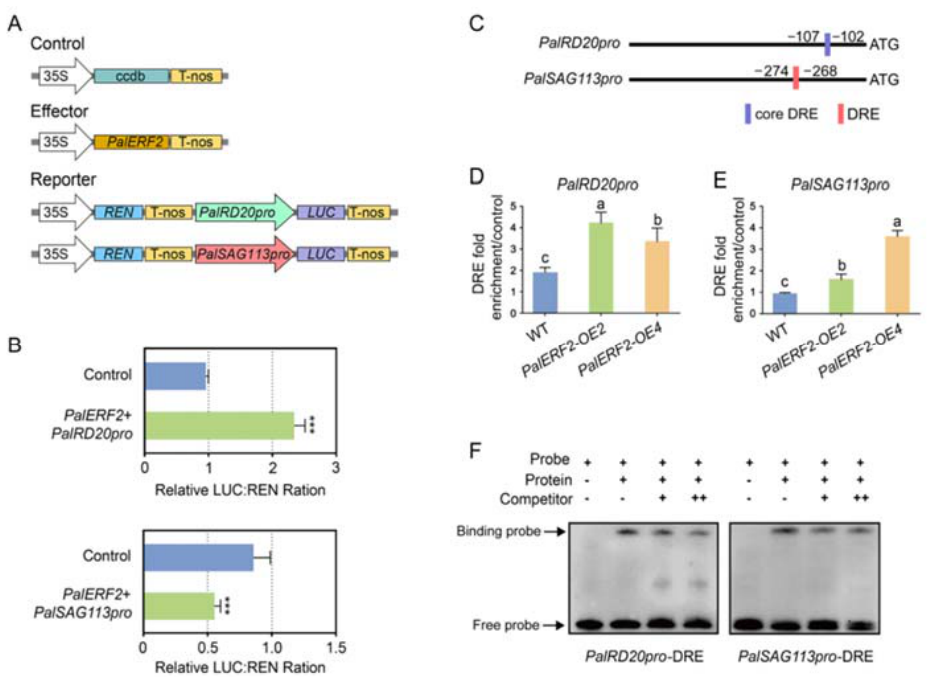
Figure 5. PalERF2 directly regulated the expression of PalRD20 and PalSAG113 . ( A ) Structures of effector and reporters employed in Dual-luciferase assay. ( B ) Transient co-expression of effector and reporter vectors in N. benthamiana leaves. Data shown as mean ± SD ( n = 3). Asterisks indicate significant differences compared to control by Student’s t -test, ***, p < 0.01. ( C ) Distribution of DRE and core DRE motifs in the promoter of PalRD20 and PalSAG113 . ( D , E ) ChIP-qPCR demonstrated that PalERF2 bound to the promoter region of PalRD20 and PalSAG113 containing DRE in vivo. Significant differences were analyzed by Duncan’s test ( p < 0.05, n = 5). Different letters indicate statistically significant differences. ( F ) EMSA demonstrated that PalERF2 bound to the DRE in the PalRD20 and PalSAG113 promoters. Unlabeled cold probes as a competitor to compete with labeled probes. + means the cold probe is 20 times the labeled probe, ++ means 50 times. The arrows mark the binding probe and free probe.